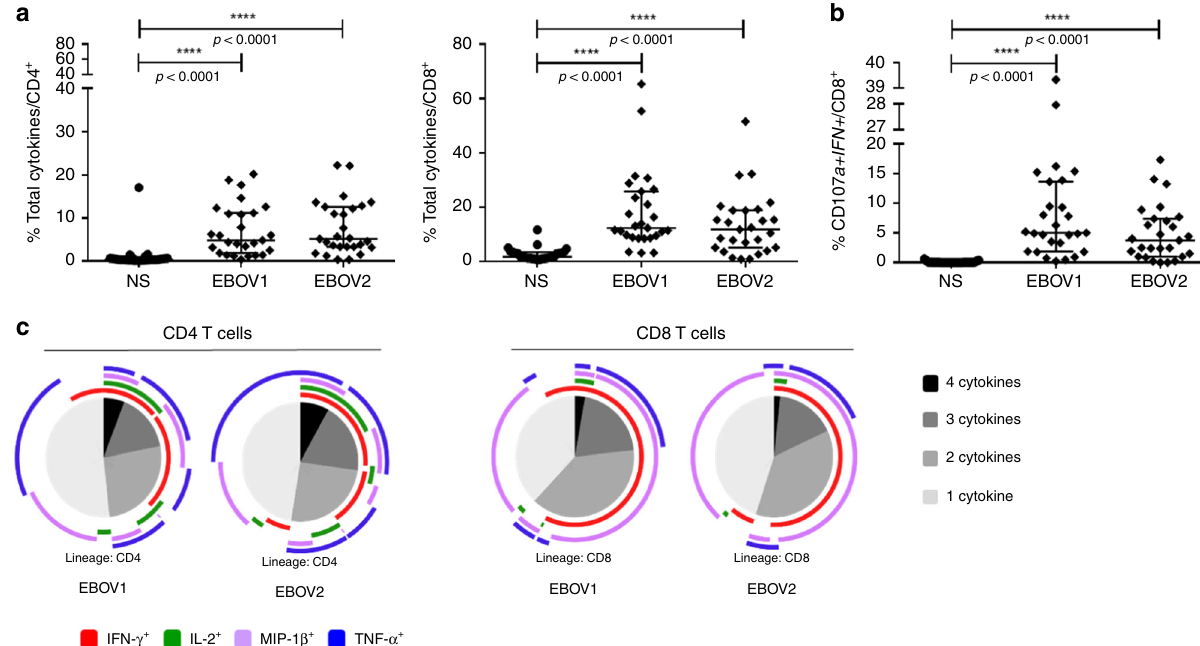
Fig. 3 Robust and polyfunctional responses in EBOV_S. EBOV GP-speci fi c CD4 + T cell (left panel) and CD8 + T cell (right panel) responses of EBOV_S ( n = 27) after 9 days of EBOV GP-speci fi c (EBOV1 and EBOV2 peptide pools) T cell expansion in vitro (all cytokines) ( a ). Analysis of the co-expression of CD107a and IFN- γ by EBOV GP-speci fi c CD8 T cells from EBOV_S ( n = 27) after 9 days of antigen-speci fi c T cell expansion in vitro ( b ). Median values ± IQR are shown, and Friedman ’ s test was used for comparisons. Functional composition of EBOV GP-speci fi c CD4 + and CD8 + T cell responses ( c ). Responses are color coded according to the combinations of cytokines produced. The arcs identify cytokine-producing subsets (IFN- γ , IL-2, MIP-1 β , and TNF) within the CD4 + and CD8 + T cell populations. Source data are provided as a Source Data fi le.